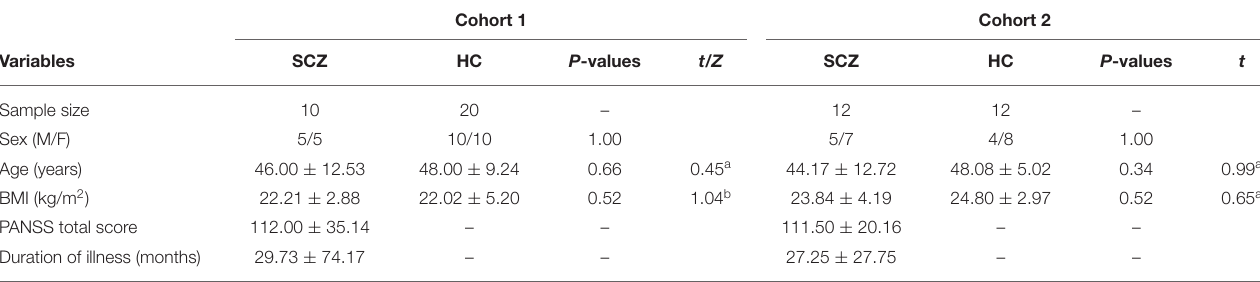
TABLE 2 | The clinical characteristics of the subjects.